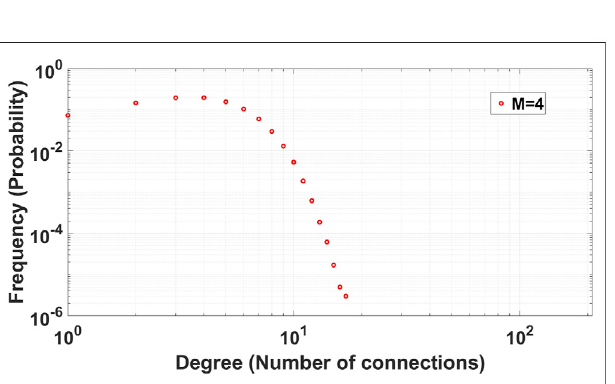
FIGURE 7 | Schematic of a generated network for Bitcoin